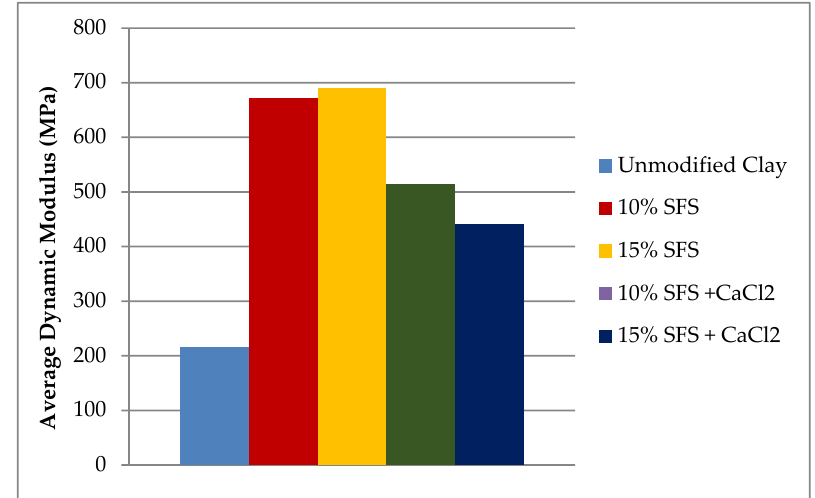
Figure 8. Comparison of the dynamic modulus generated by the 8-mm impactor for each mix.